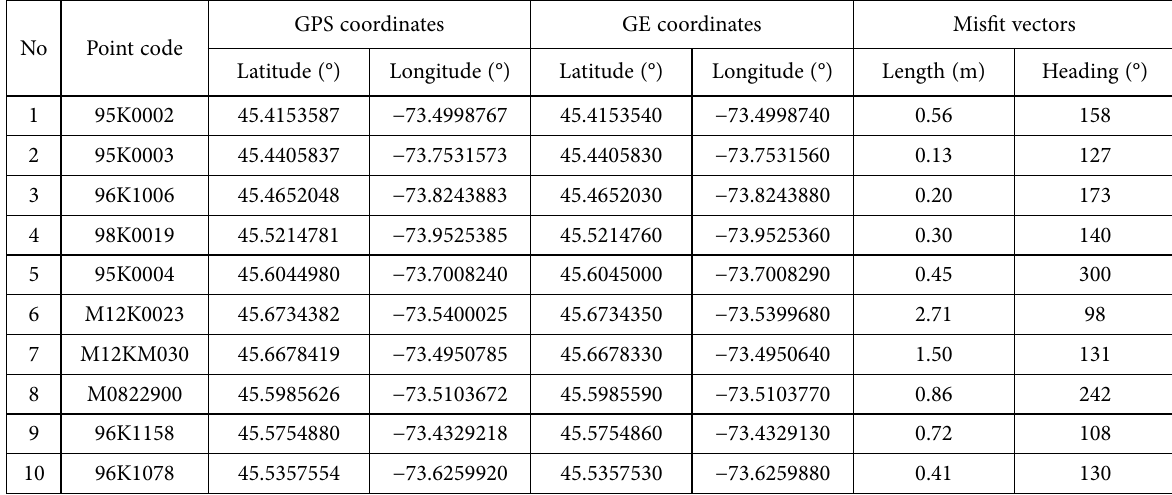
Table 1. True GPS and GE coordinates and their differences (misfit vectors) for the selected GPS points No Point